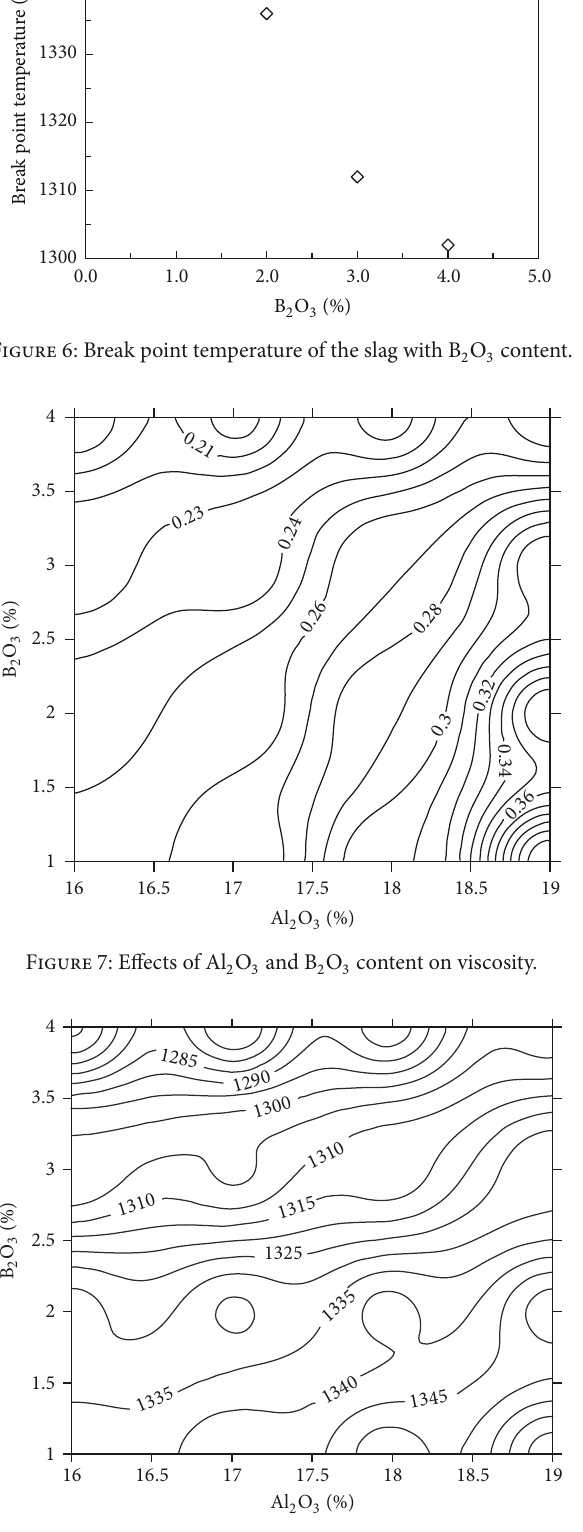
Figure 8: Effects of Al 2 O 3 and B 2 O 3 content on break point tem- perature.